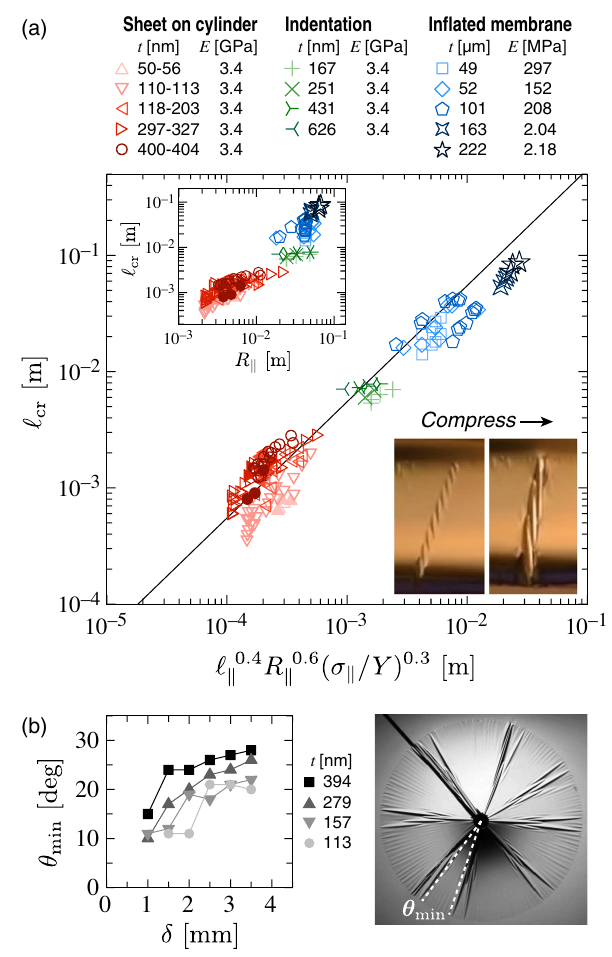
FIG. 4. Emergent scales in the crumpled phase. (a) Crumple length l , measured from optical images in the sheet-on- cr cylinder, indentation, and inflated membrane setups. The sheet thickness and modulus are varied over a wide range by using rubber ( E ∼ 2 MPa), polyethylene ( E ∼ 200 MPa), and polysty- rene ( E ¼ 3 . 4 GPa) sheets. We also vary the surface tension in the sheet-on-droplet setup (open symbols, 72 mN = m; closed symbols, 36 mN = m). The data are reasonably described by a simple expression involving l k , R k , and σ k =Y [solid line, Eq. (1)]. increasing upon compression; this The two images show l cr behavior may account for some of the scatter in the data. Inset: l cr versus R k , which does not collapse the data. (b) Minimum angular separation between crumpled regions in indentation. The angular spacing grows with indentation depth δ and is larger for thicker